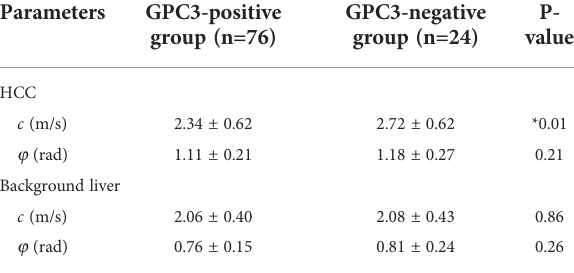
TABLE 3 Group mean and standard deviation of the mechanical parameters c (stiffness) and j ( fl uidity) in the two groups with different GPC3